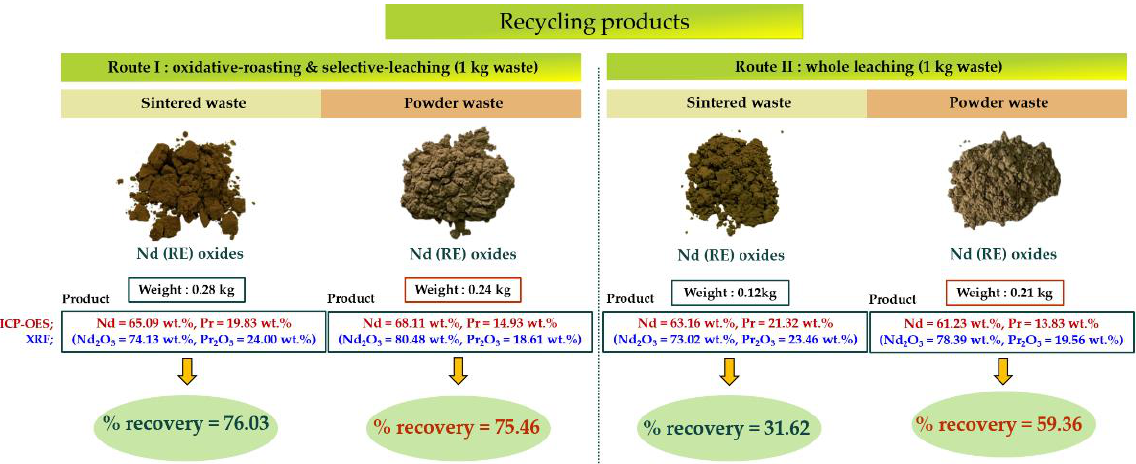
Figure 15. The material balance of sintered NdFeB recycling under route II: whole leaching.